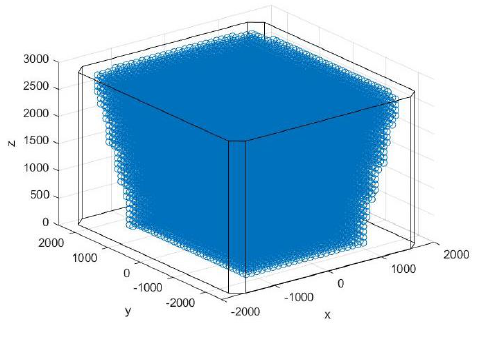
Figure 4. General kinematics of the cable robot (6 DOF; 8 cables).